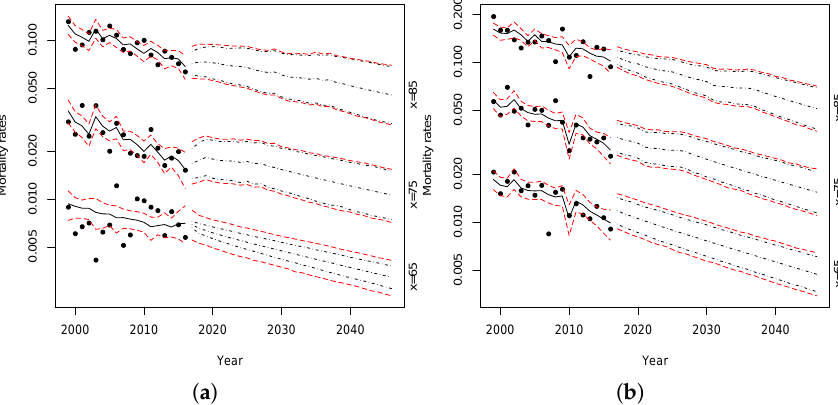
Figure 16. Mortality rate projections at age 65, 75, 85 with parameters uncertainly with Plat–LC model for ( a ) female Maltese population, ( b ) male Maltese